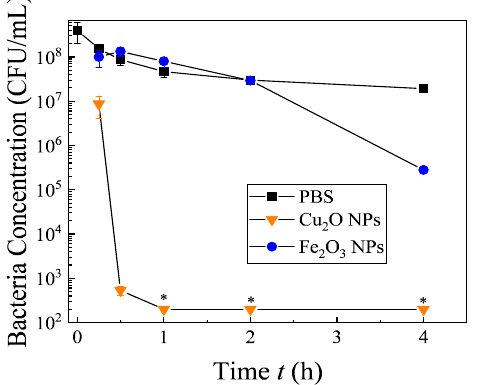
Figure 9. Bacteria inhibition tests for 1 mg/mL control Fe 2 O 3 and Cu 2 O NPs in corresponding growth media. “*”: ND/below detection limit (200 CFU/mL). These tests were carried out in a dark environment. The results represent 3 independent inhibition experiments and are expressed as mean and standard deviation of CFU/mL.